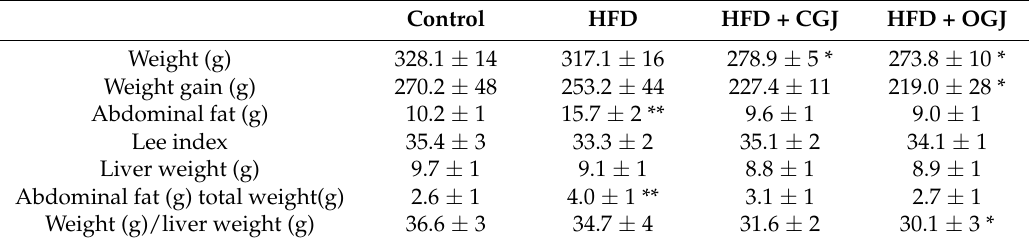
Table 3. Evaluation of morphometric parameters after 12 weeks of treatment with high-fat diet (HFD), conventional grape juice (CGJ), and/or organic grape juice (OGJ).